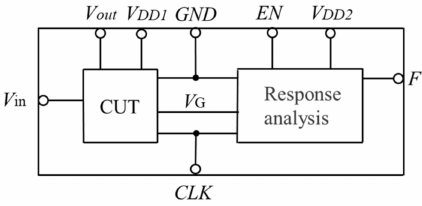
Figure 2. The proposed BIST schematic.